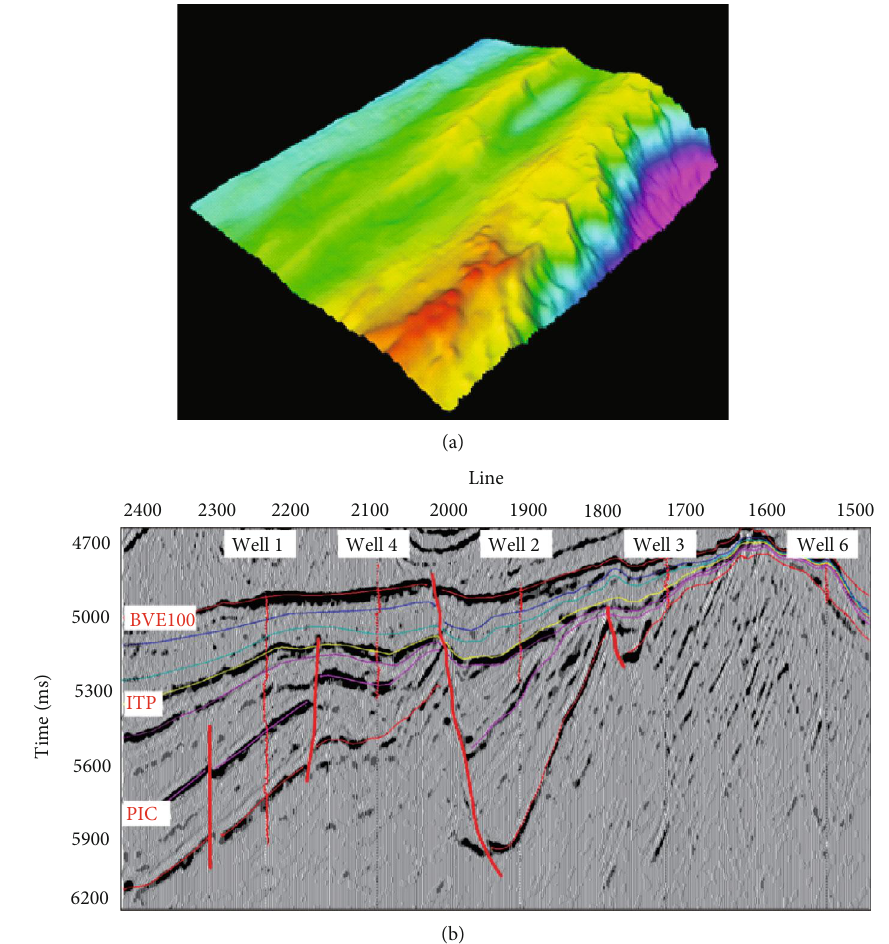
Figure 4: (a) The paleogeography of the target area and (b) fault development pro fi le in the study area.